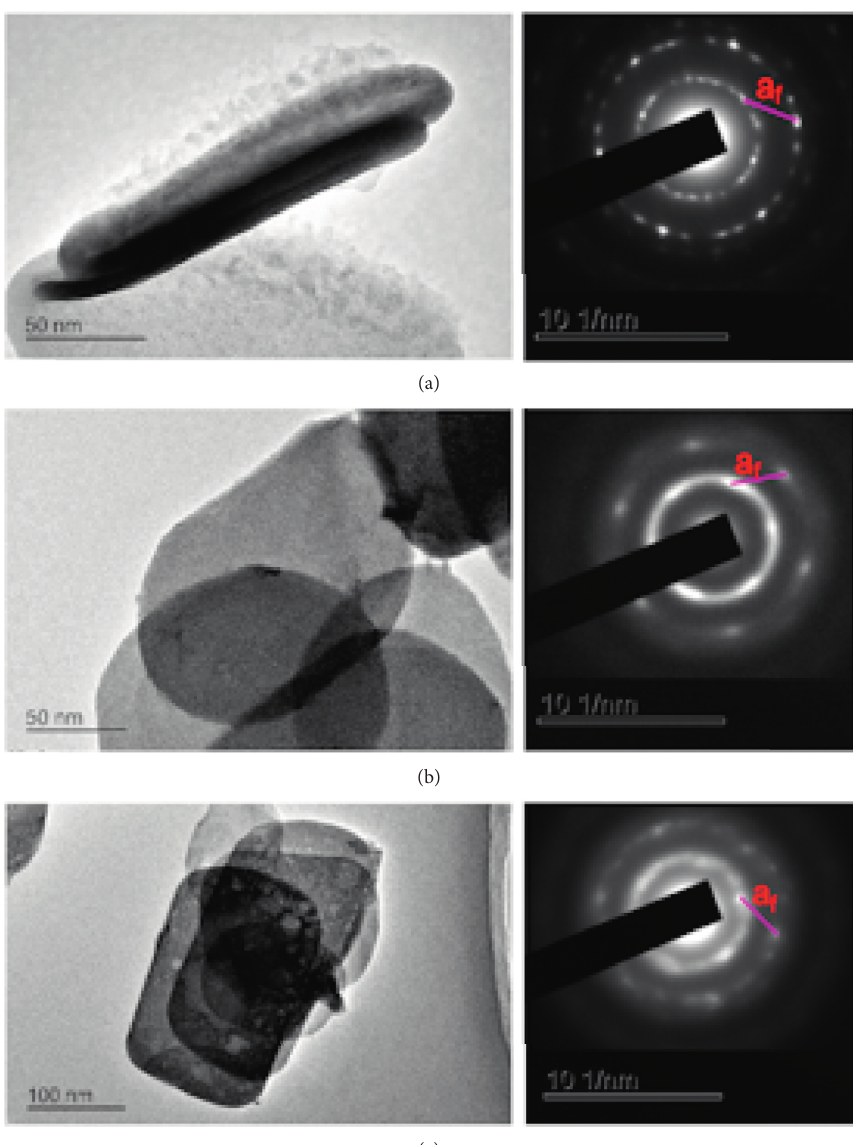
Figure 3: HRTEM and SAED images of (a) LEuH-Cl aggregates, (b) LEuH-flocs nanosheets, and (c) LEuH-flocs +fluoride